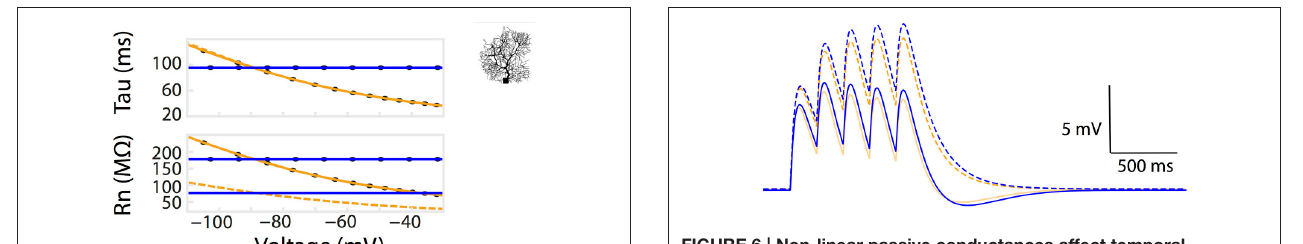
FIGURE 6 | Non-linear passive conductances affect temporal integration of post-synpatic potentials. Temporal summation of excitatory post-synaptic potentials in an Ohmic model (blue) and a GHK model (orange) (same models as in Figure 2 ). Solid and dotted lines represent summation in the presence and absence of I h respectively. The maximal conductance of I h used in this simulation is identical to G Leak of the GHK leak current. some of which may have more complex properties than